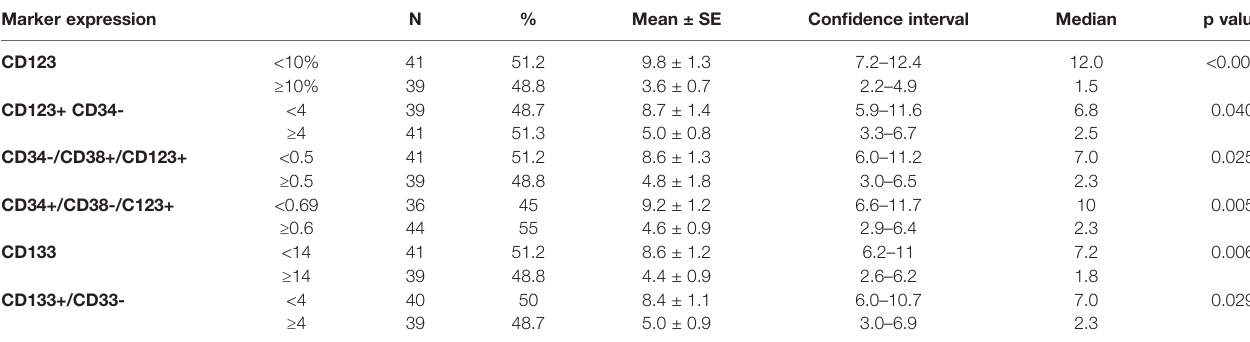
TABLE 3 | Impact of leukemia stem cell frequency (CD34/CD38/CD123) at diagnosis on overall survival in 80 acute myeloid patients. Marker expression N